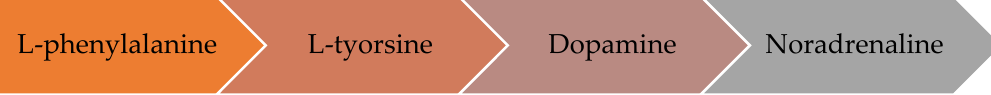
Figure 2. The synthesis pathway from L-phenylalanine to noradrenaline including all its intermediary products. Dopamine acts as an important metabolite for the emotional response and reward system [64].